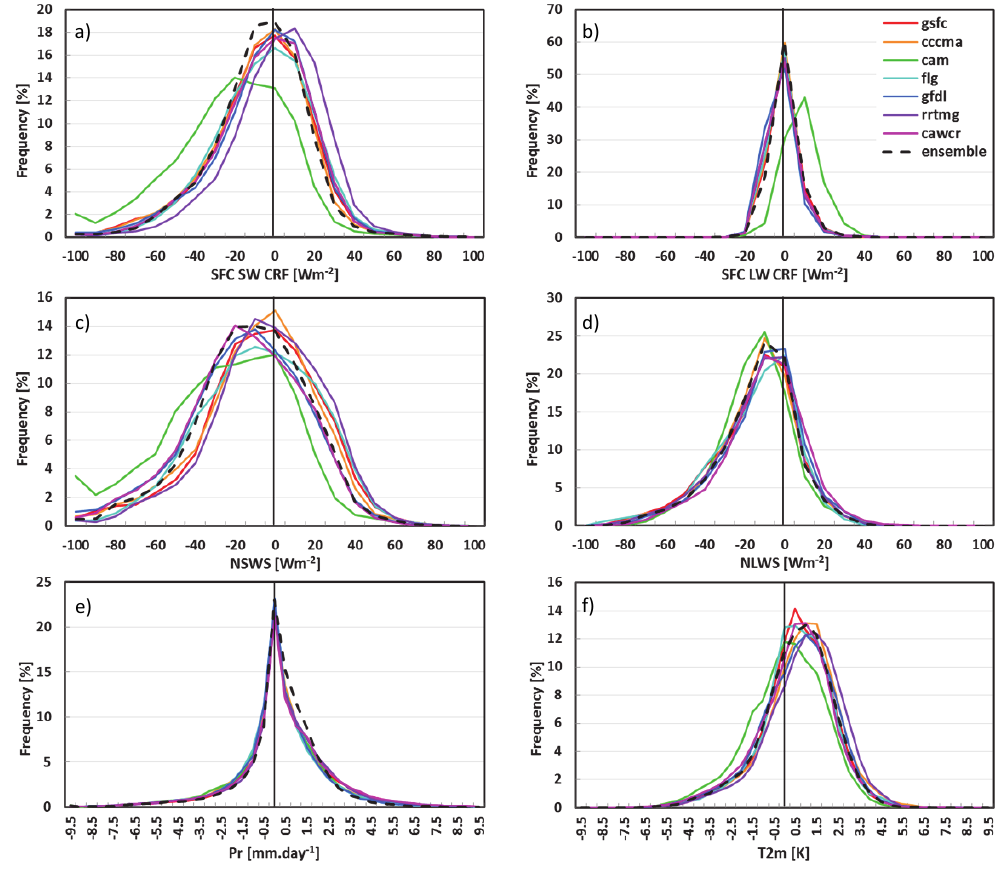
Fig. 10. Spatial frequency distributions of CWRF biases in surface net SW (left) and LW (right) CRFs ( a , b ), net radiative fuxes ( c , d ), Pr ( e ) and T2m ( f ) among the seven major radiation packages. The statistics are based on monthly means during June, July, and August 2004 over all US land